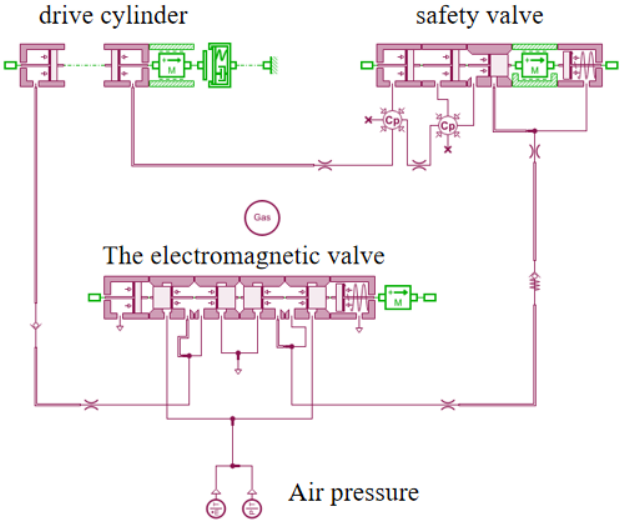
Figure 6. High-speed cylinder simulation model.